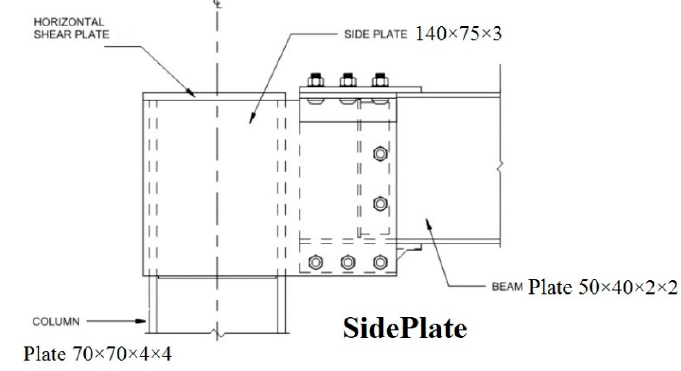
Table 2. Summary of Tested Specimens.